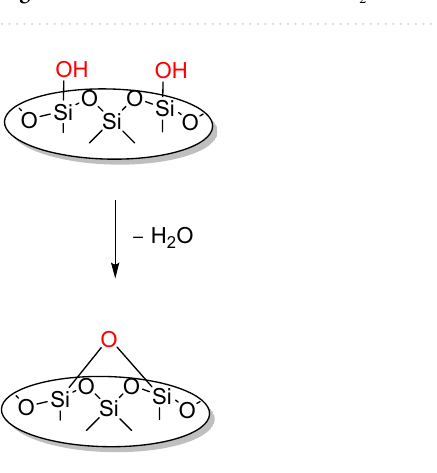
Figure 4. Functionalization with LiAlO 2 and Melilite s.s.